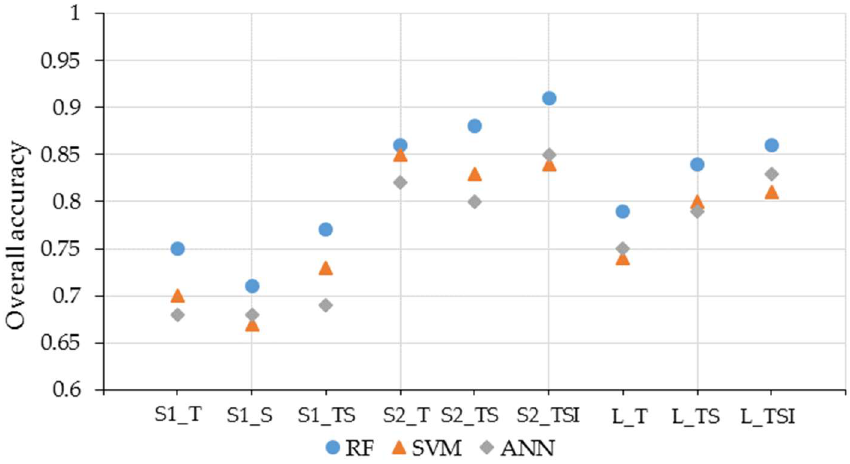
Figure 6. Performance of the three classifiers for nine classification scenarios.